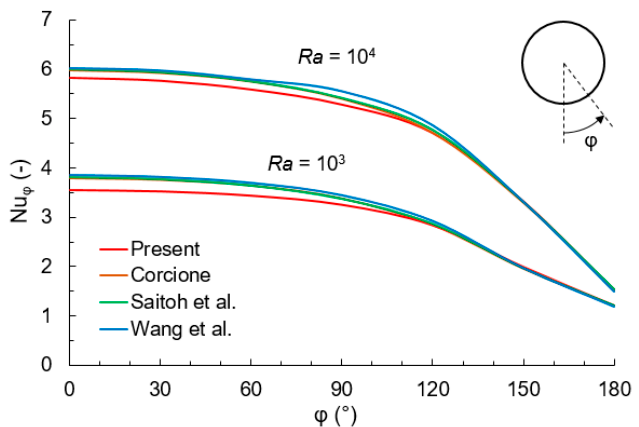
Figure 4. The comparison of the local Nusselt numbers Nu φ of the single cylinder with other authors at Ra = 10 3 and Ra = 10 4 .